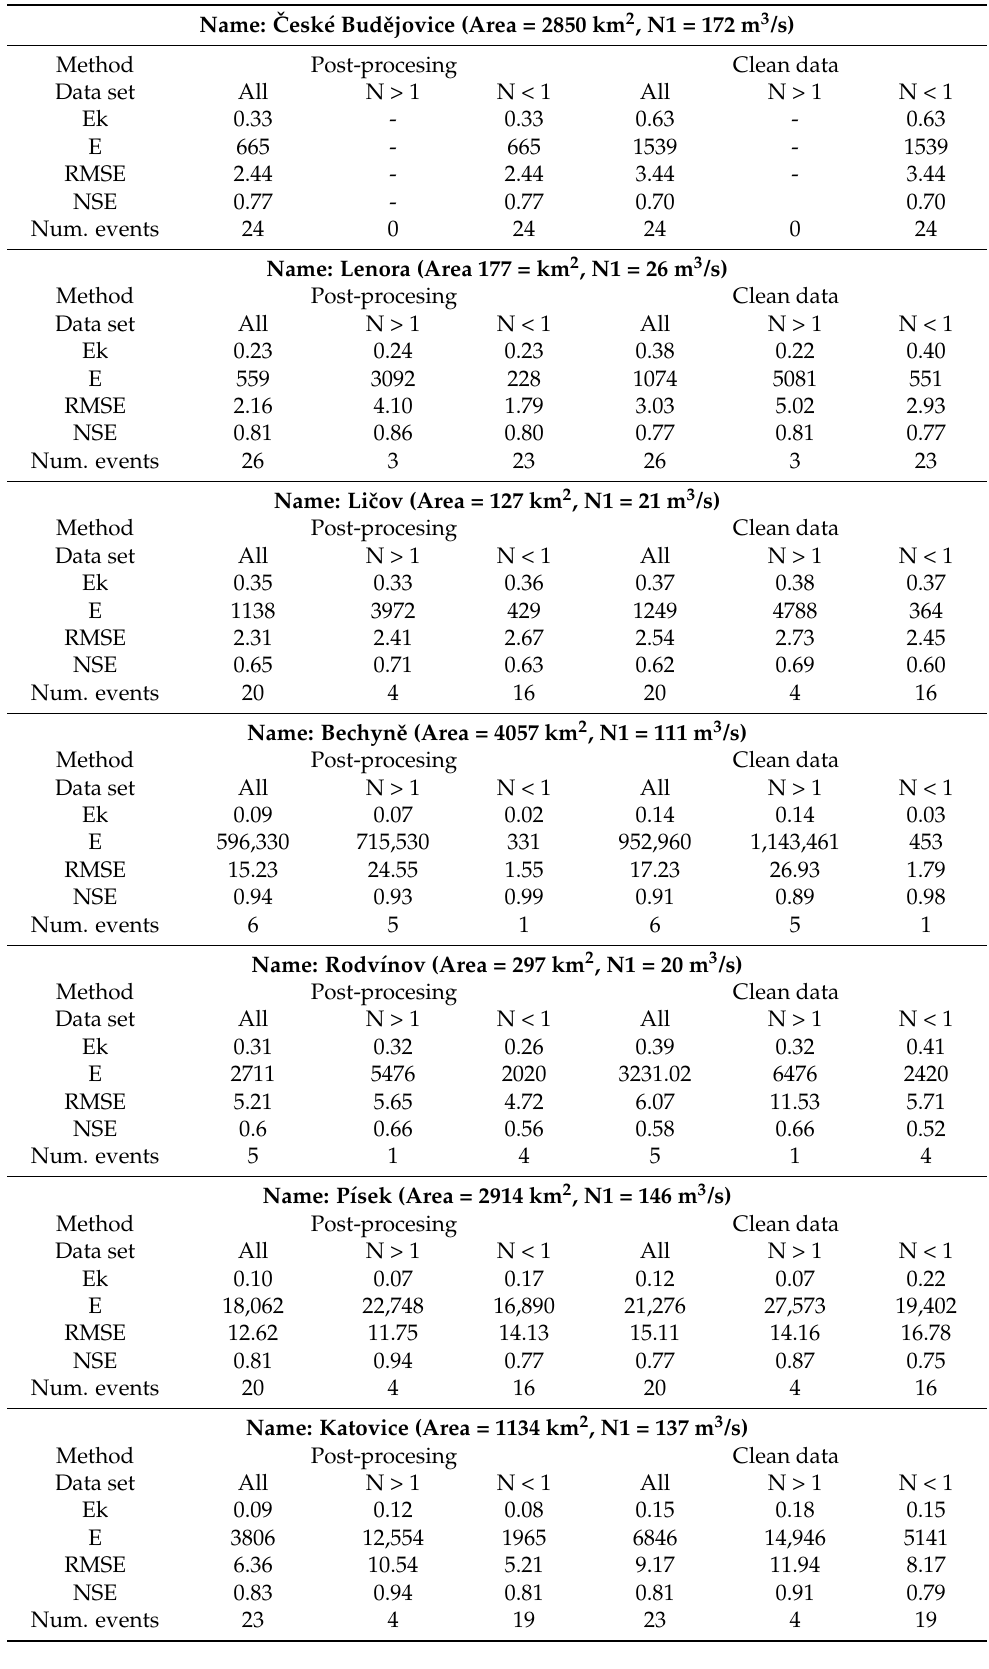
Table 4. Criteria results for the individual